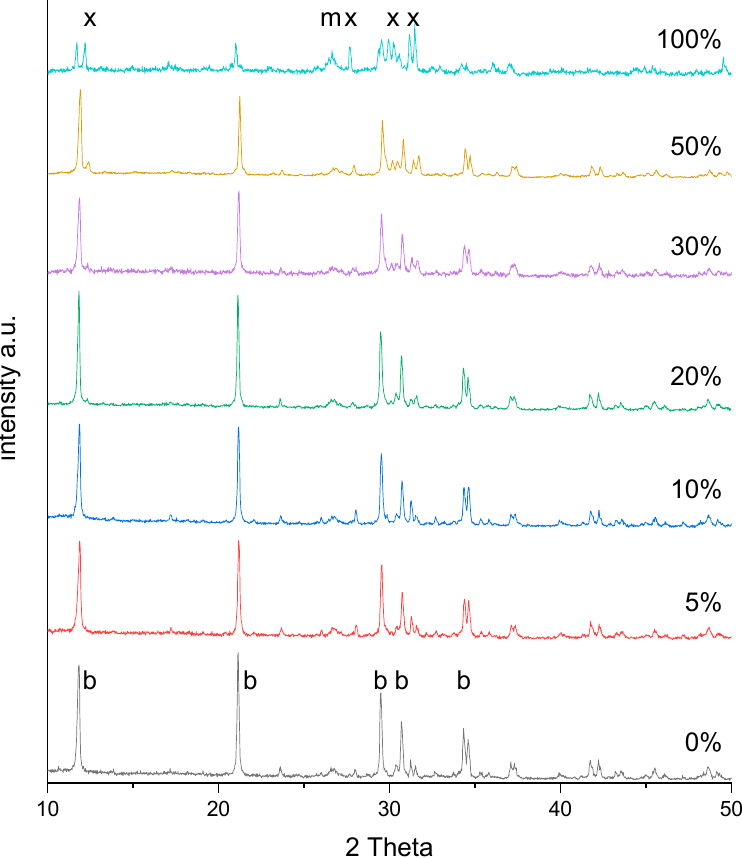
Figure 1. X-ray di ff raction patterns of BCB samples with 0%, 10%, 20%, 30%, 50%, and 100% β -TCP substitution by baghdadite after one day setting in deionized water at 37 ◦ C with marked peaks of brushite (b, ICDD-PDF #09-0077)), monetite (m, ICDD-PDF #09-0080), and baghdadite (x, ICDD-PDF #54-0710). Table 2. Brushite lattice plane reflex positions adjusted to the corundum reference for sample BCB50%.